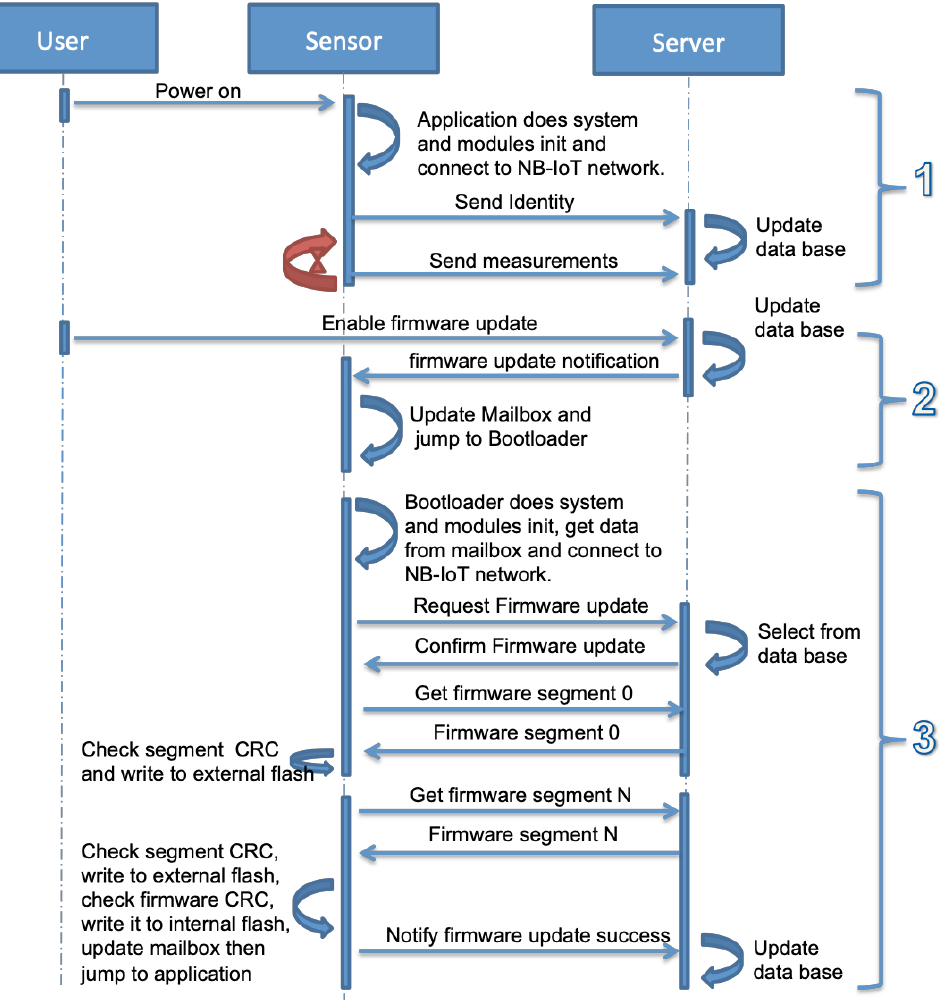
Figure 6. Firmware update